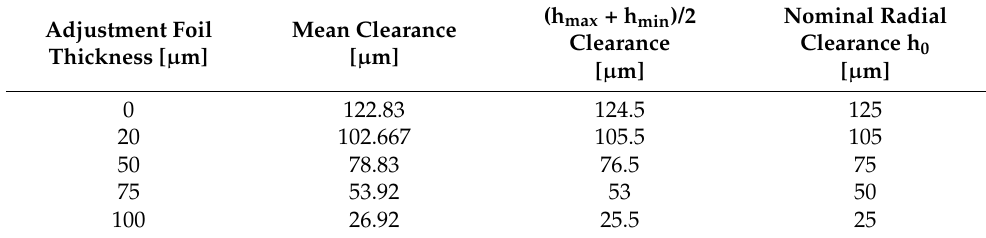
Table 1. Summary of the results of the bearing gap measurements.